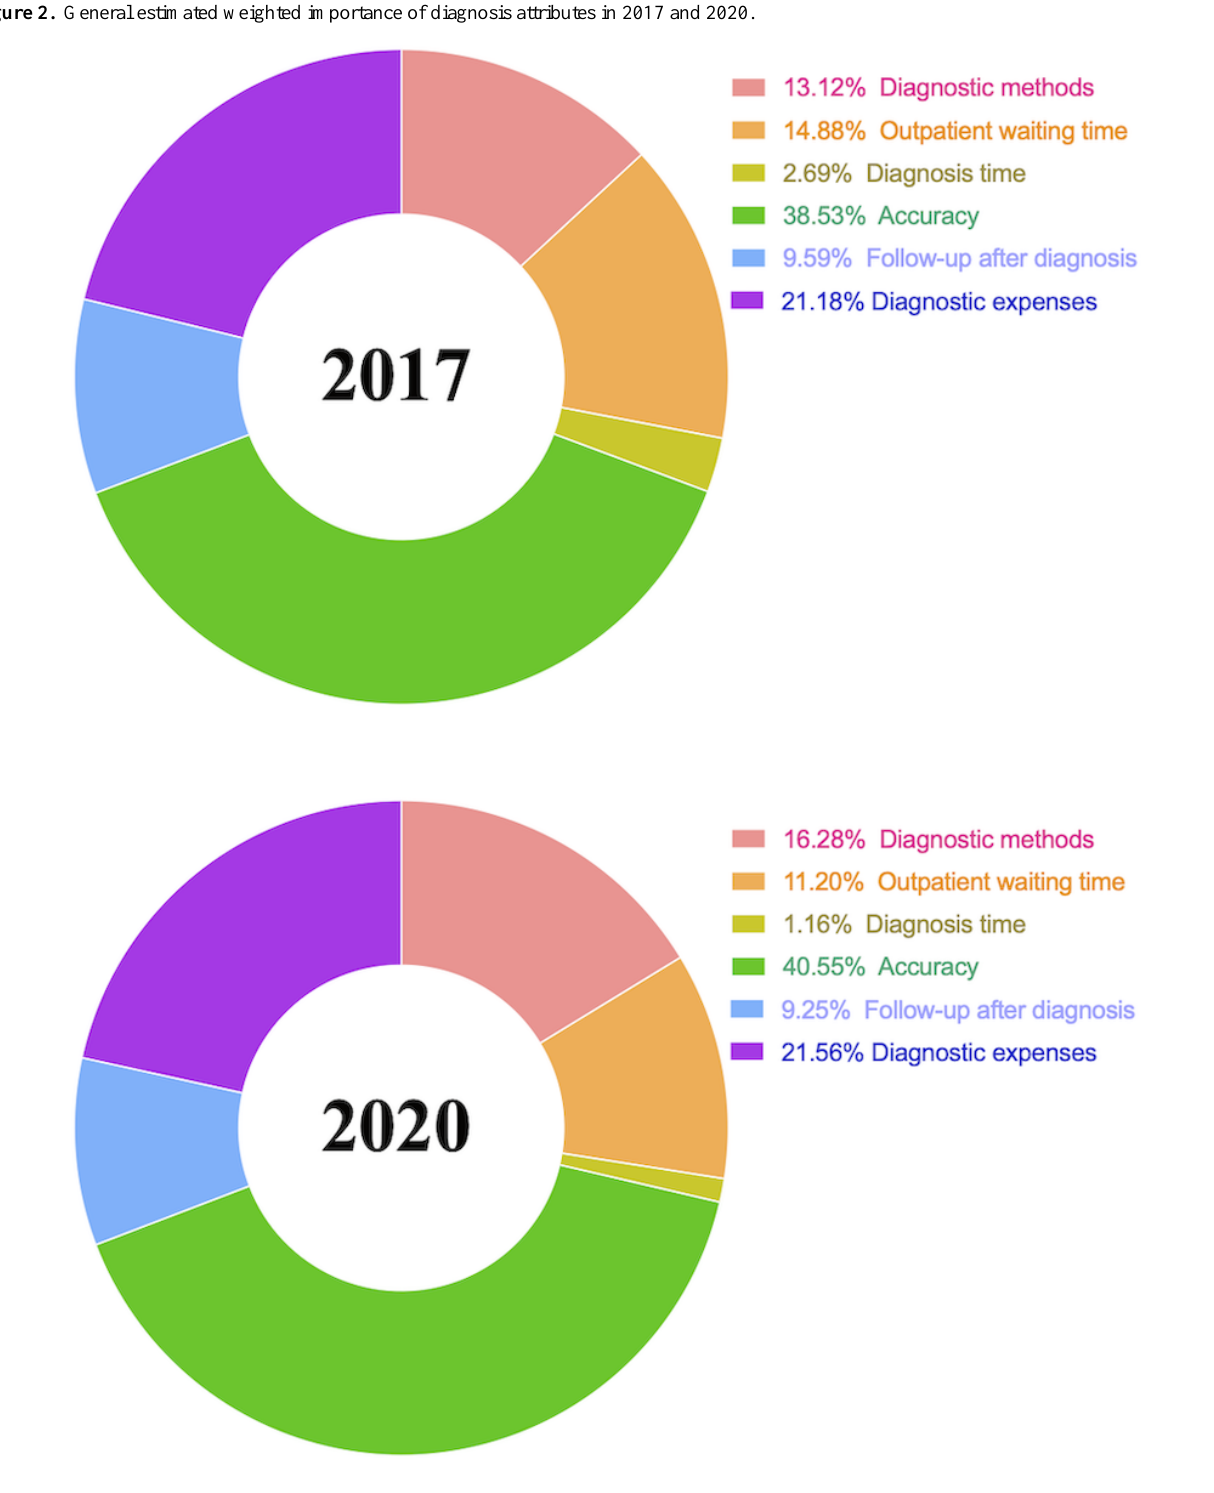
Figure 2. General estimated weighted importance of diagnosis attributes in 2017 and